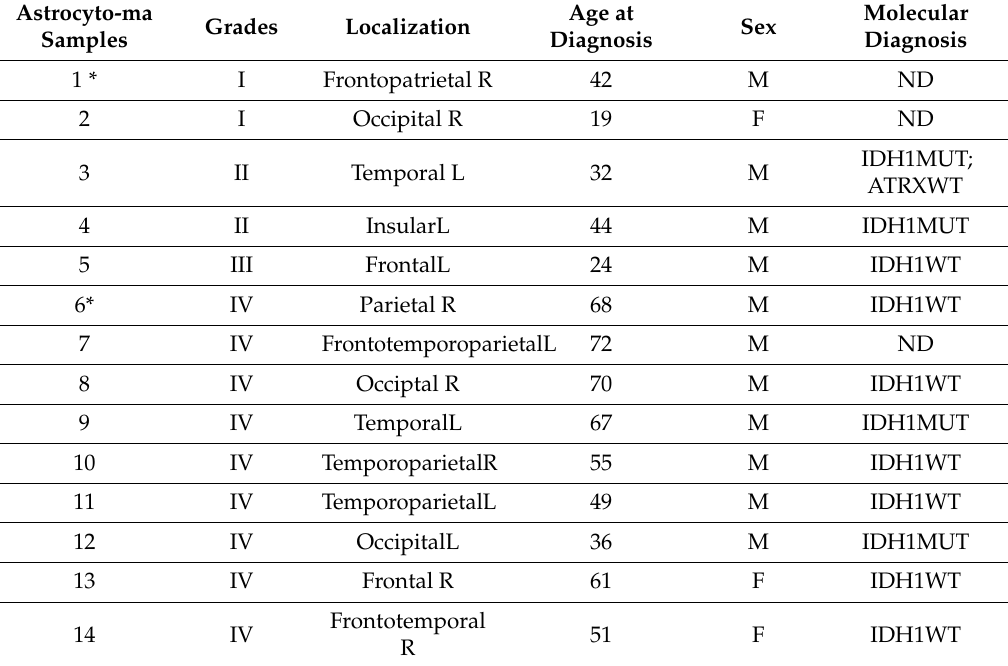
Table 1. Clinical and epidemiological data for collected astrocytoma